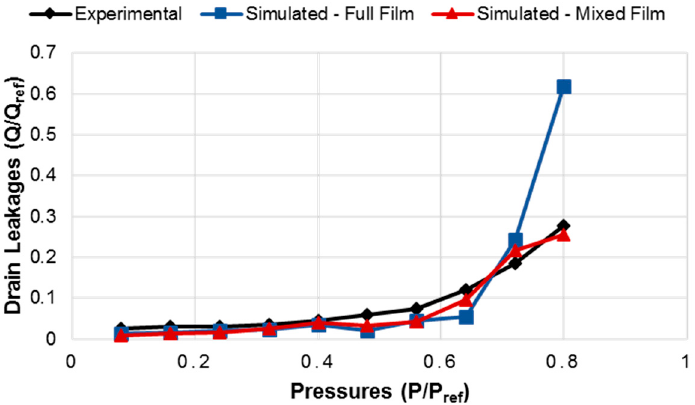
Figure 16. Comparison of measured drain leakages with the simulated ones from the full and mixed film models at an operating speed of 1500 rpm.